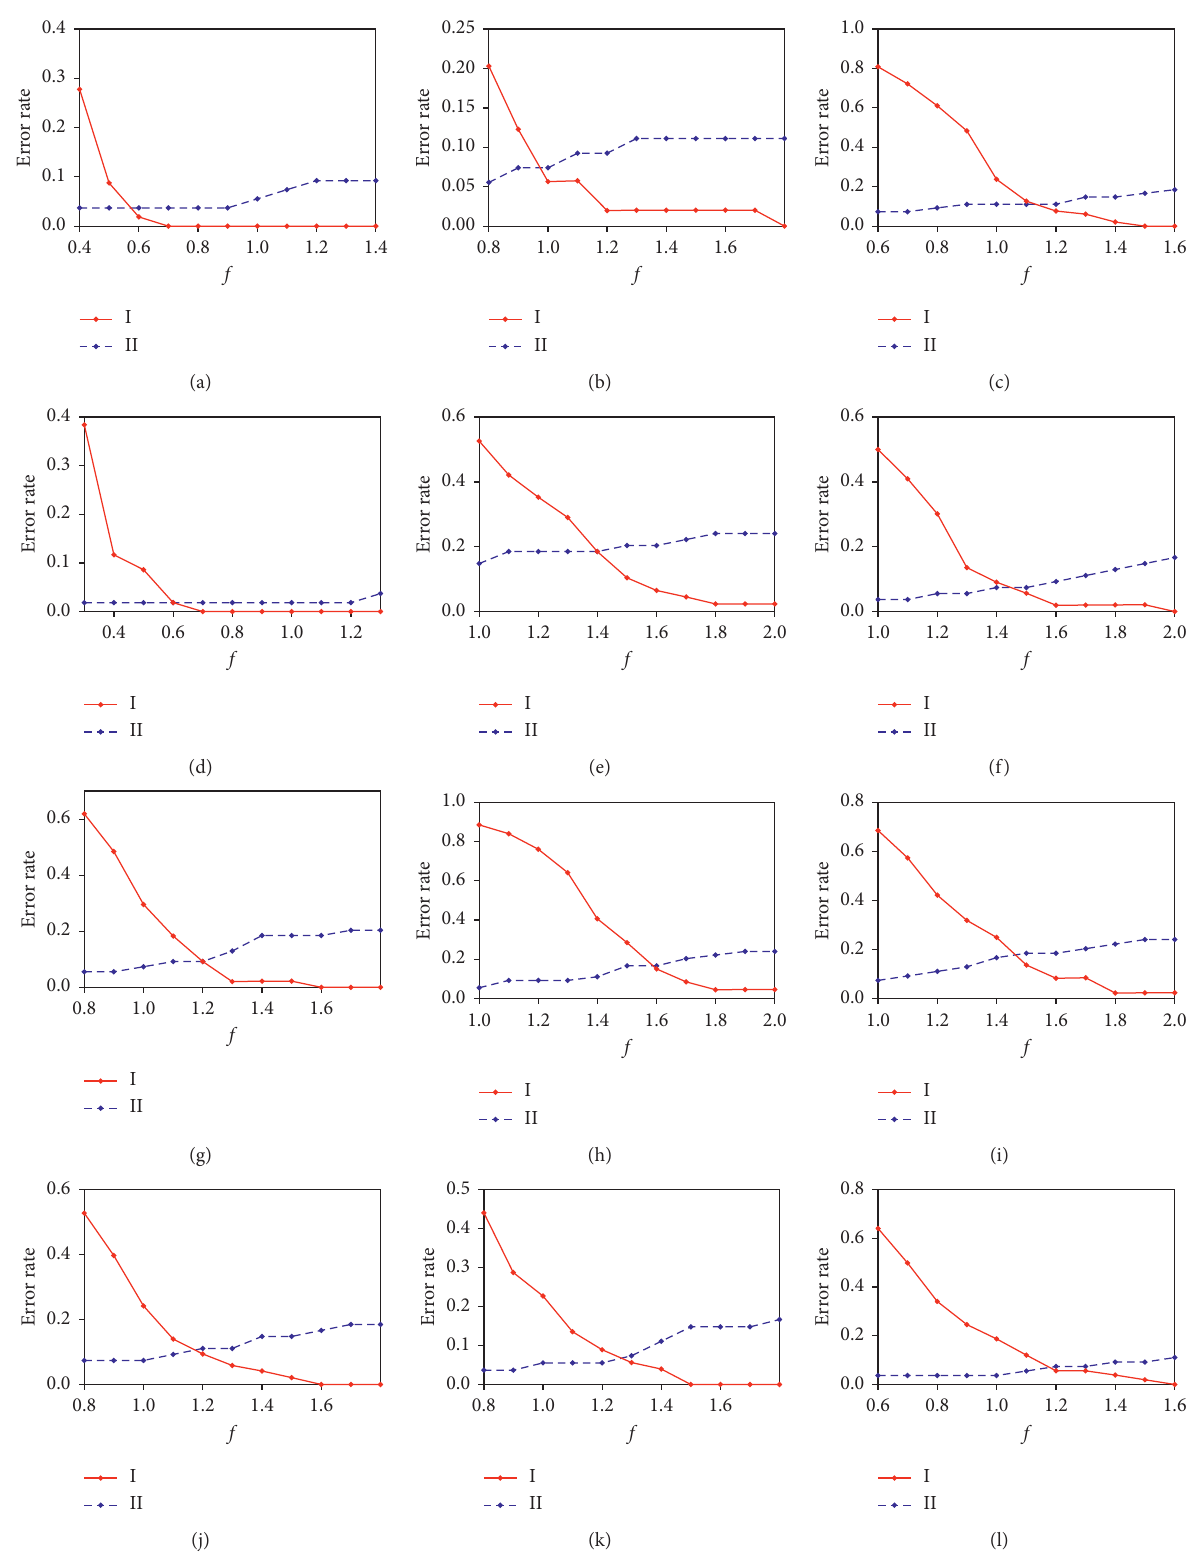
Figure 8: Comparison of the two types of errors under different f values, taking (a) IKR-BH, (b) IDW-BH, (c) SRT-BH, (d) IKR-HK, (e) IDW-HK, (f) SRT-HK, (g) IKR-LS, (h) IDW-LS, (i) SRT-LS, (j) IKR-MH, (k) IDW-MH, and (l) SRT-MH as